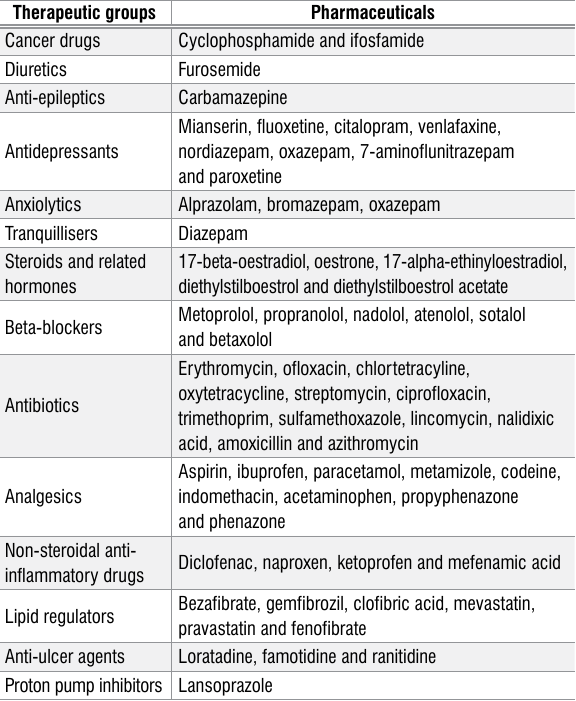
Table 1: Pharmaceuticals that have been found in aqueous ecosystems (adapted from Nikolaou et al. 31 and Gros et al. 32